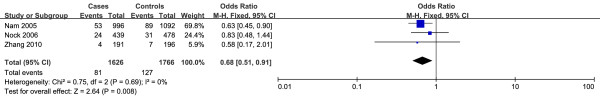
Forest plots for hOGG1 Ser326Cys polymorphism and risk of Prostate cancer in mixed population (Cys/Cys versus Ser/Cys + Ser/Ser). The squares and horizontal lines correspond to the study specific OR and 95% CI. The area of the squares reflects the weight (inverse of the variance). The diamond represents the summary OR and 95% CI.